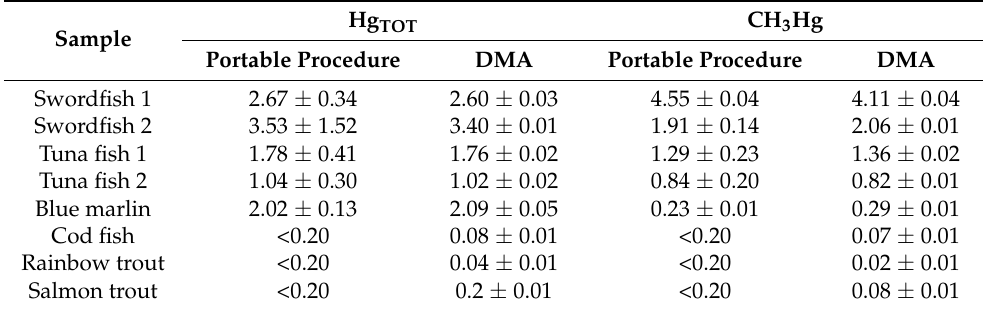
Figure 2. Voltammograms obtained using the portable kit for ( a ) Hg IN and ( b ) CH 3 Hg quantification: — tuna fish; ‧‧‧‧ first addition (5 µg ‧ L −1 ); ---- second addition (10 µg ‧ L −1 ). The concentrations of Hg TOT and CH 3 Hg achieved using the proposed portable procedure and DMA are compared in Table 2. Table 2. Concentrations (mg ‧ kg −1 ) obtained for Hg TOT and CH 3 Hg in fish samples analyzed with voltammetry and by DMA.